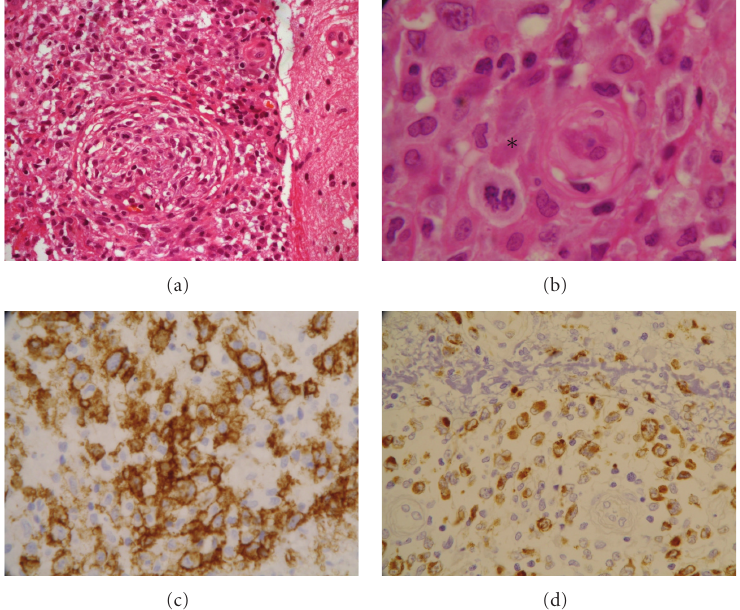
Figure 2: Cerebellar biopsy: (a) nodular granulomatouslesionwith mononuclearcells (Hematein-eosin × 40). (b) Atypical cells with mitosis ( ∗ ) (Hematein-eosin × 40). (c) Staining with anti-CD20 ( × 40): atypical cells are stained. (d) Staining with anti-EBV-LMP1 ( × 40): a lot of cells are